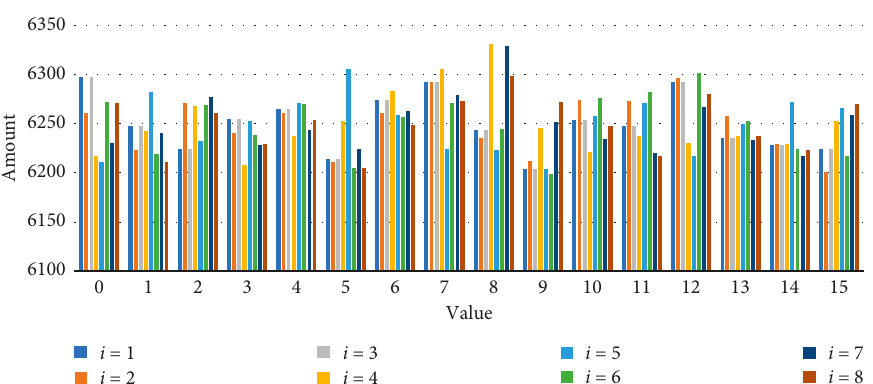
Figure 8: Distribution of 8-bit LMFSR with the different initial values.